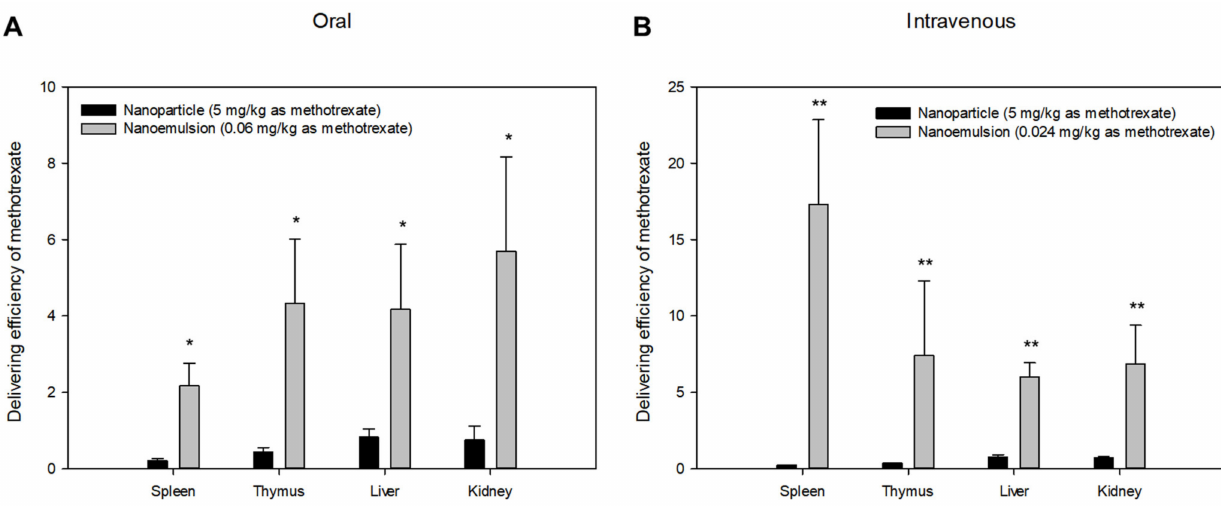
Figure 6. Mean delivering efficiencies of methotrexate to spleen, thymus, liver, and kidney at 2.5 h after oral ( A ) or intravenous ( B ) administration of methotrexate-loaded nanoparticles (- • -, 5 mg/kg as methotrexate) and methotrexate- loaded nanoemulsions (- -, 0.06 or 0.024 mg/kg as methotrexate) in rats. Vertical bars represent standard deviation of (cid:35) the mean ( n = 5). Delivering efficiency in each tissue was calculated as the ratio of the concentration in the tissues to the concentration in plasma. * p < 0.05 compared with the oral administration of nanoparticle. ** p < 0.05 compared with the intravenous administration of nanoparticle.